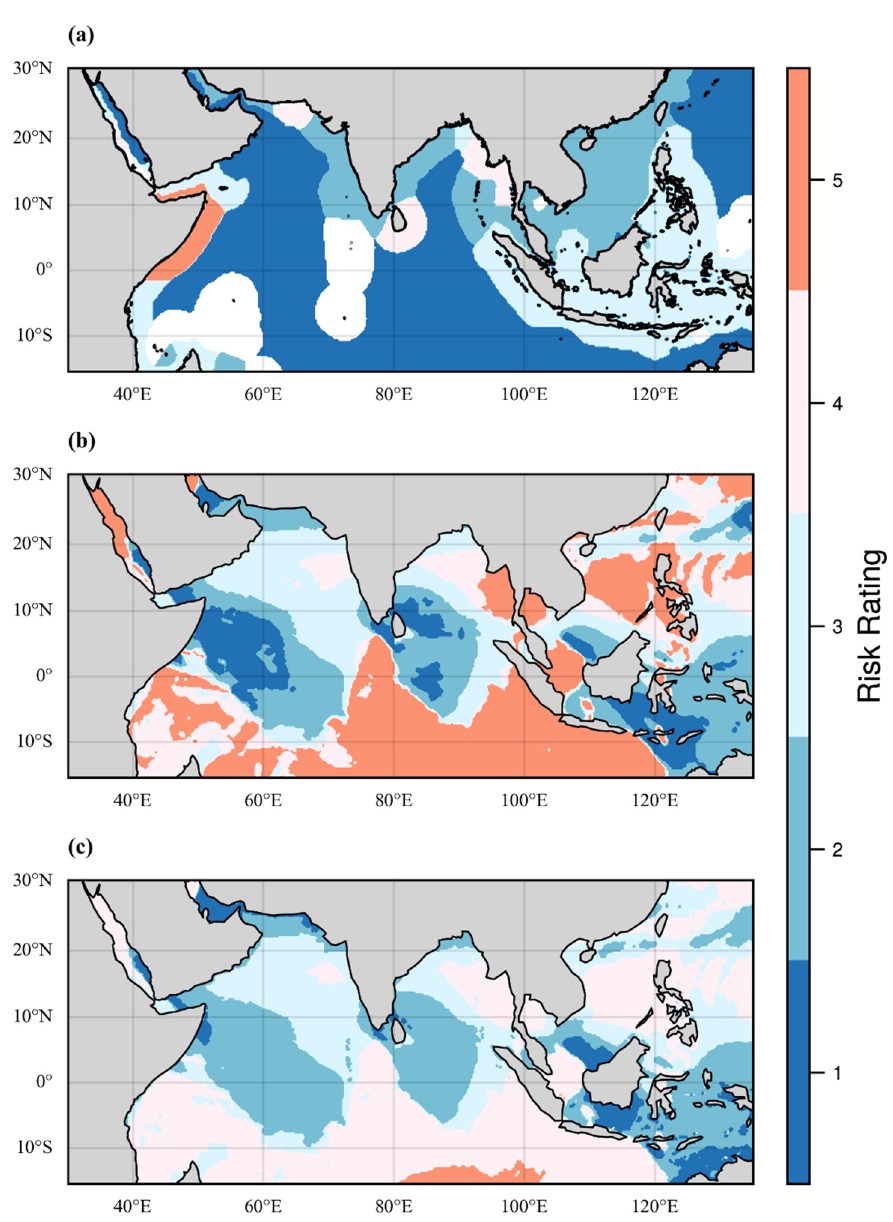
Figure 5. Results of different indicator systems in 2005: ( a ) only geo-human influences; ( b ) only wind-energy resources; ( c ) comprehensive risk.